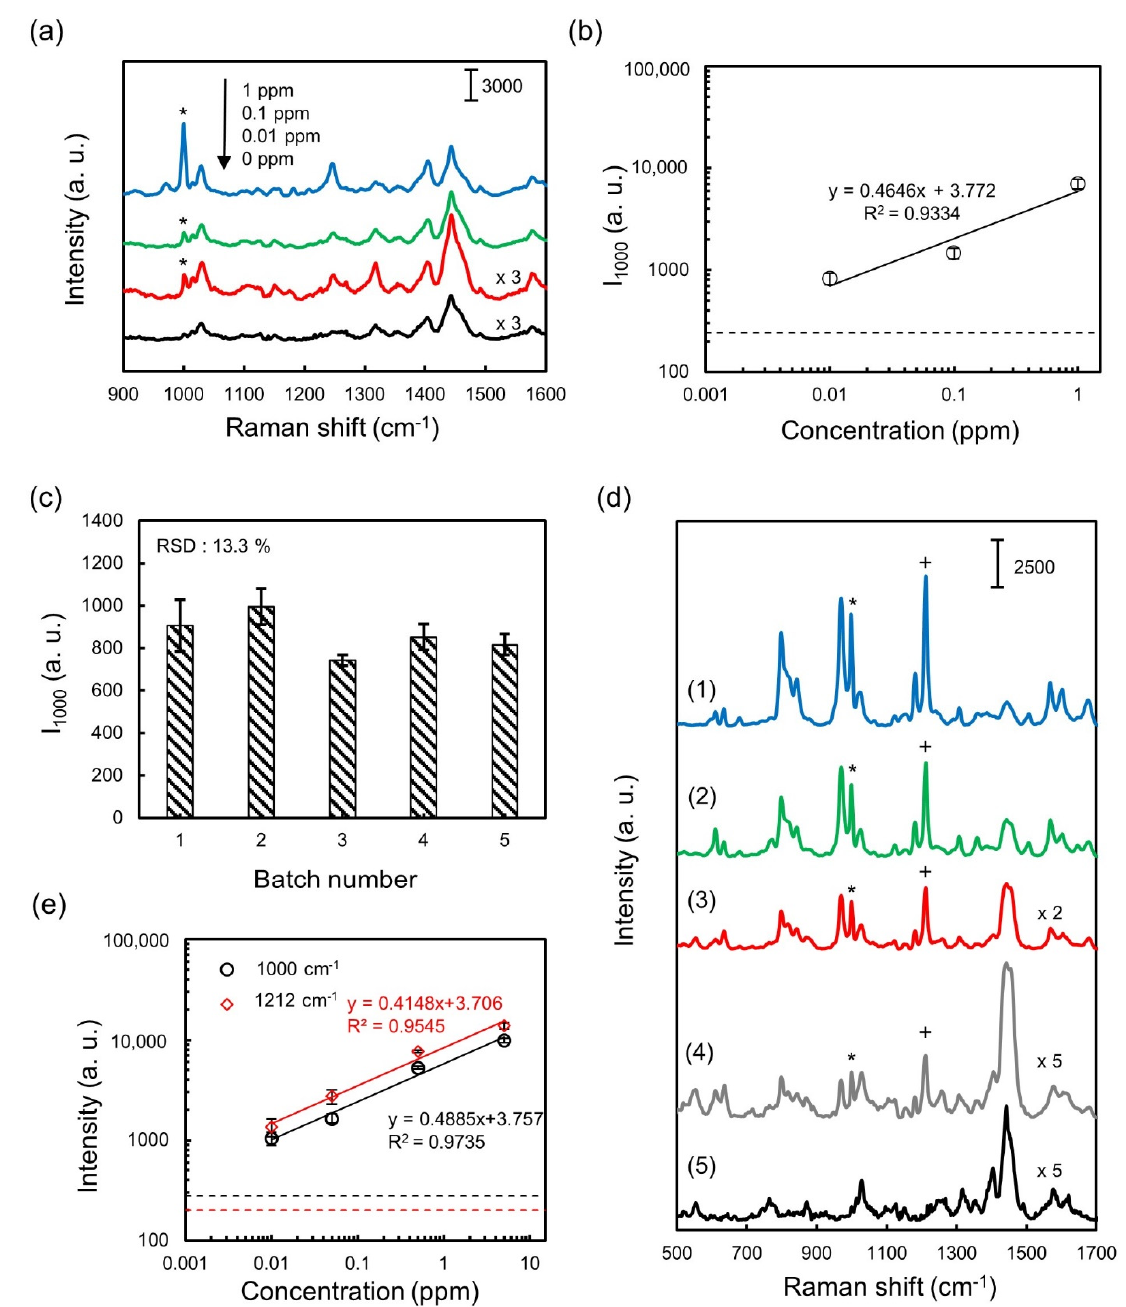
Figure 7. SERS detection of MC and 4-MMC in urine. ( a ) SERS spectra of MC in urine measured after sample pretreatment. The characteristic Raman peak of MC at 1000 cm − 1 is marked with “*”. ( b ) A plot of the intensity of the 1000 cm − 1 peak versus MC concentration. Error bars show standard deviations with n = 30. The straight line is the linear regression line, and the dotted line indicates mean plus 3 σ of the 1000 cm − 1 peak of the blank sample. ( c ) The intensities of the 1000 cm − 1 peak measured from 5 urine samples containing 0.01 ppm MC. Error bars show standard deviations with n = 10. ( d ) SERS spectra of urine samples containing both MC and 4-MMC measured after sample pretreatment. The concentration of both MC and 4-MMC was 5, 0.5, 0.05, 0.01, and 0 ppm for the SERS spectrum (1), (2), (3), (4), and (5), respectively. The characteristic Raman peak of MC at 1000 cm − 1 and the characteristic Raman peak of 4-MMC at 1212 cm − 1 are marked with “*” and “+”, respectively. ( e ) A plot of the intensity of the t 1000 cm − 1 peak versus MC concentration and the intensity of the 1212 cm − 1 peak versus 4-MMC concentration. Error bars show standard deviations with n = 10. The straight lines are the linear regression lines, and the black and red dotted lines indicate mean plus 3 σ of the 1000 and the 1212 cm − 1 peak, respectively, of the blank